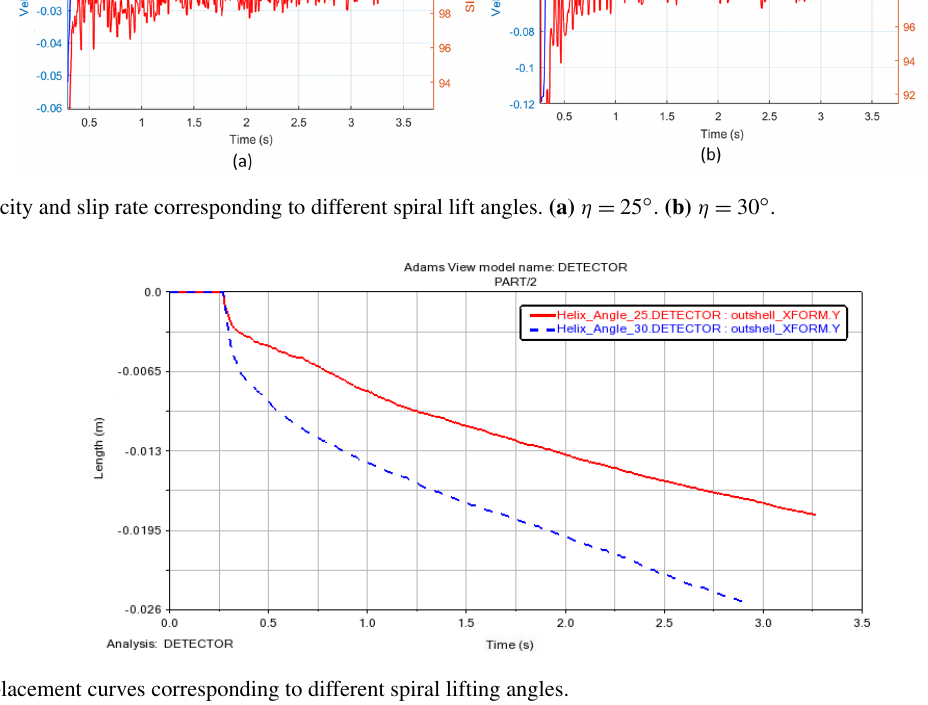
Figure 18. Displacement curves corresponding to different spiral lifting angles.